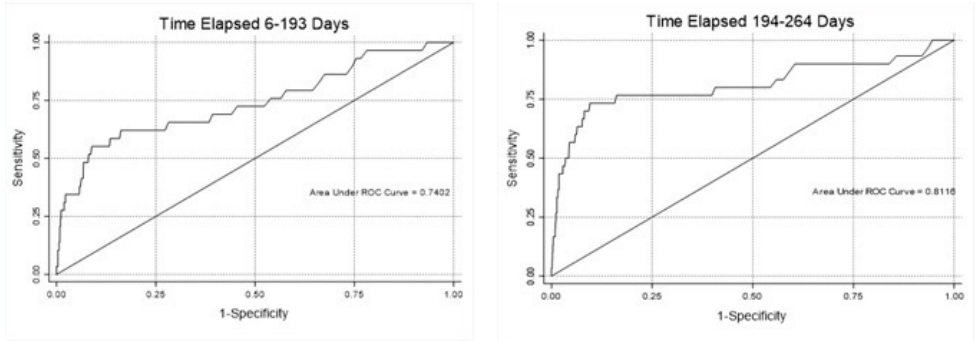
Table 2. Discriminant power of antibody-S IgG titer, evaluated as a function of time elapsed since second vaccination dose.